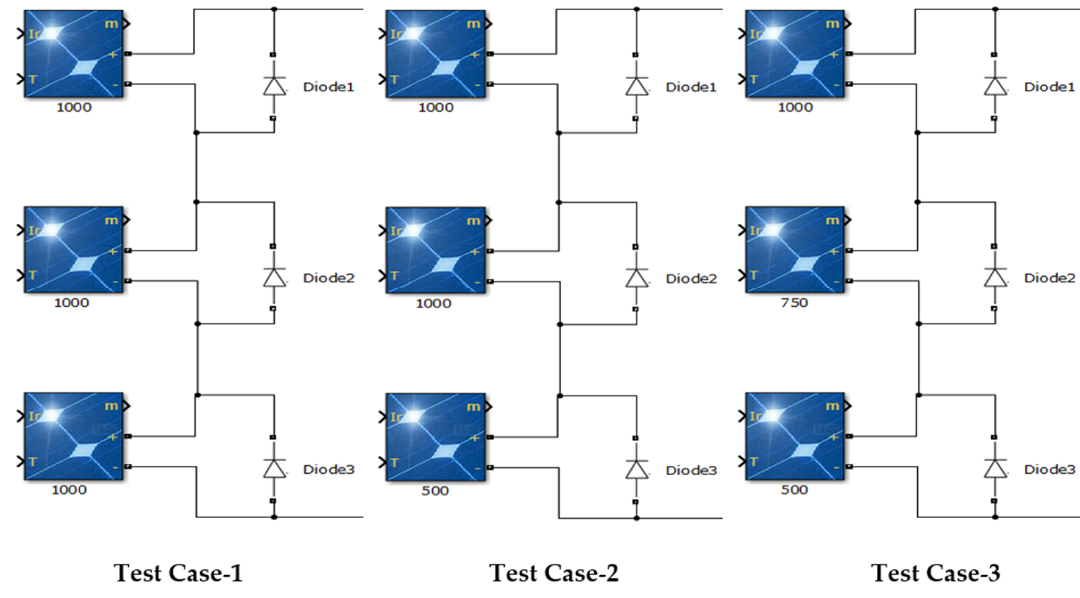
Figure 18. Test cases for 3S PV system .